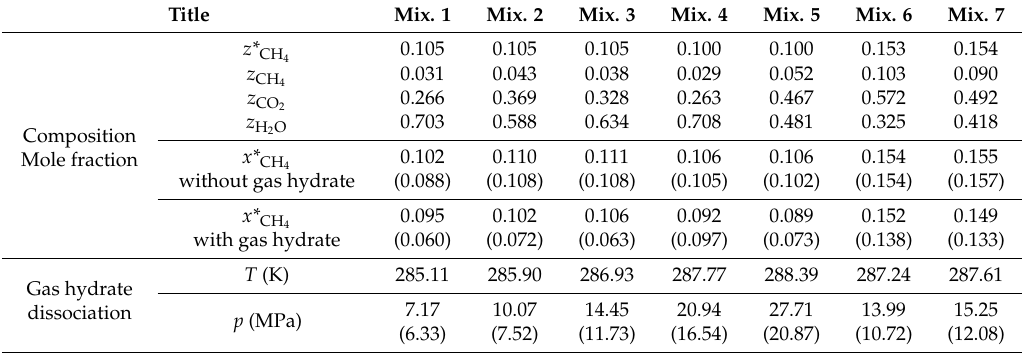
Table 5. Experimental data of H-L H Values inside brackets are CSMGem [47] model values applied on the